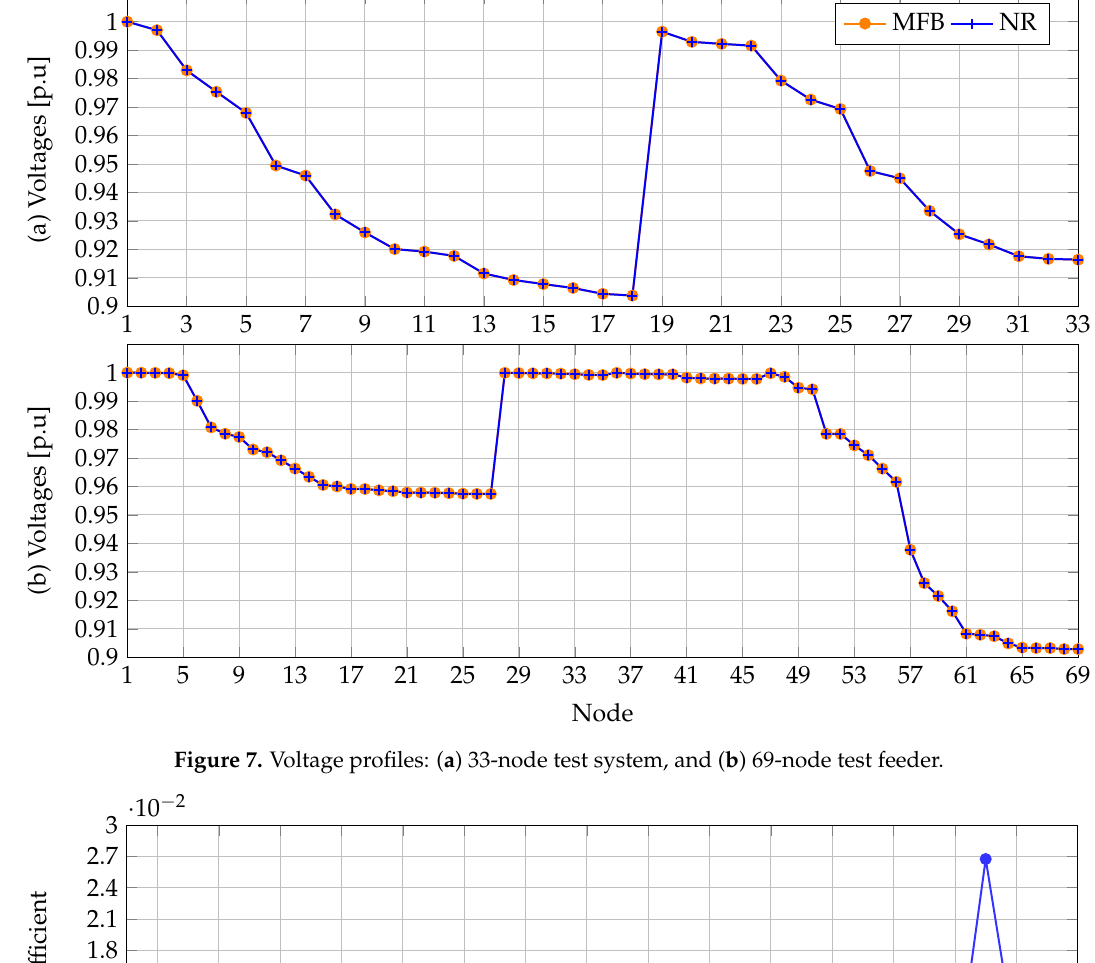
Figure 7. Voltage profiles: ( a ) 33-node test system, and ( b ) 69-node test feeder.